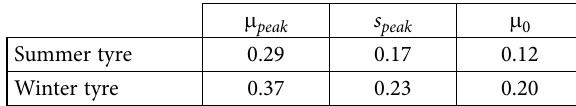
Table 8. Differences in slip referring to m peak adhesion coefficient Table 10. Differences in slip referring to m peak adhesion coefficient (tyre producer 2, wet surface, v = 60 km/h, T = –15 ° C) (tyre producer 2, snowy surface, v = 25 km/h, T = –2 ° C) m m peak s peak 0